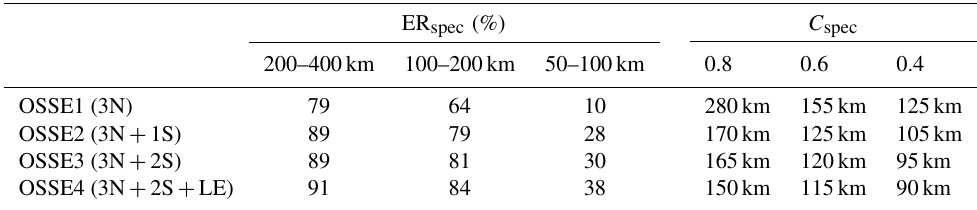
Table 6. Spectral analysis. Columns 2–4 represent the error reduction (%) with respect to OSSE0 (control simulation) at different spatial scales. Columns 5–7 denote spectral coherence (0.8–0.4) in the OSSEs; the values show the spatial scale (expressed as km) at which the coherence falls below 0.8, 0.6 and